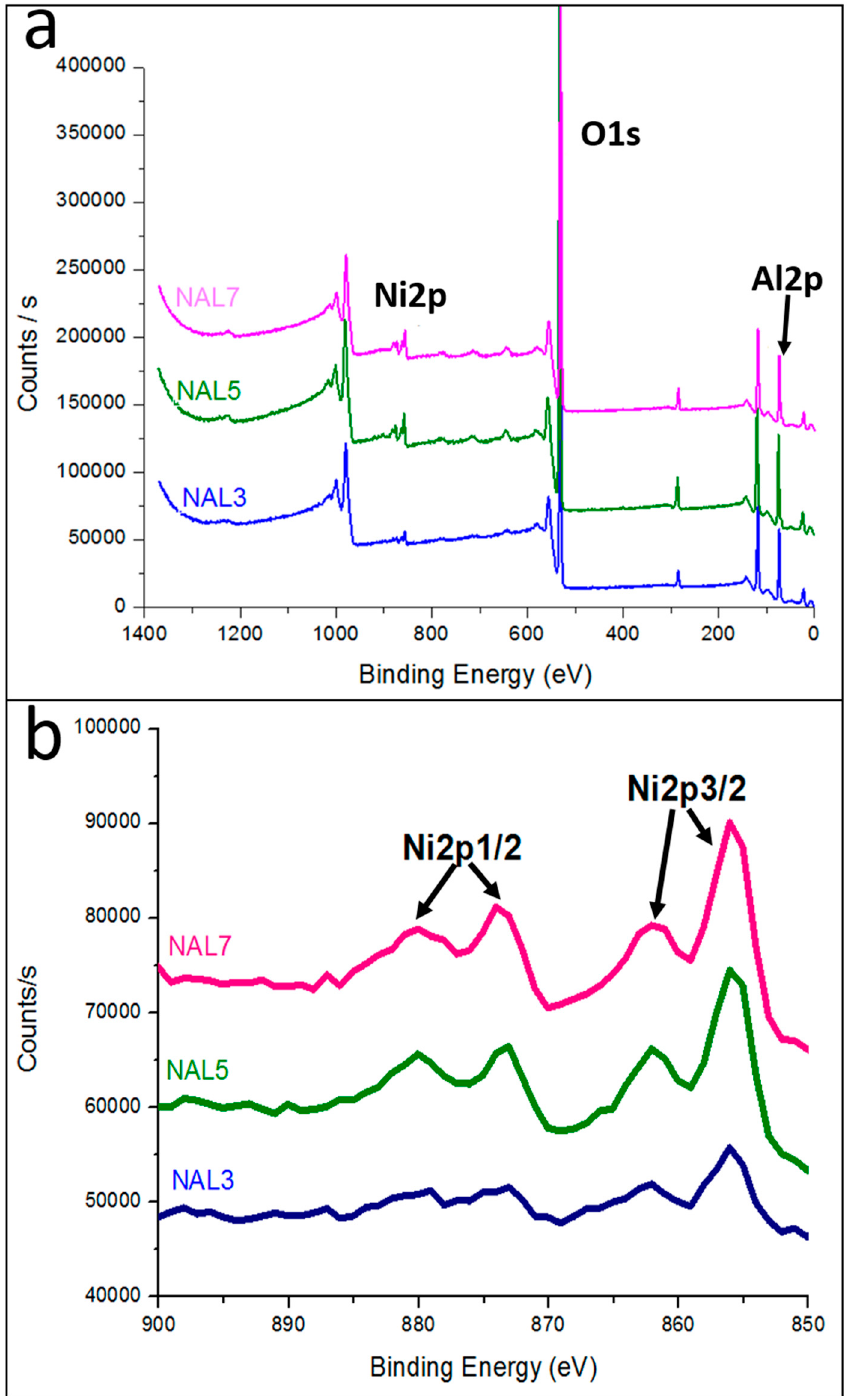
Figure 2. ( a ) XPS spectra general of Ni/ γ‐ Al 2 O 3 catalysts; ( b ) identification of the Ni states in these catalysts.